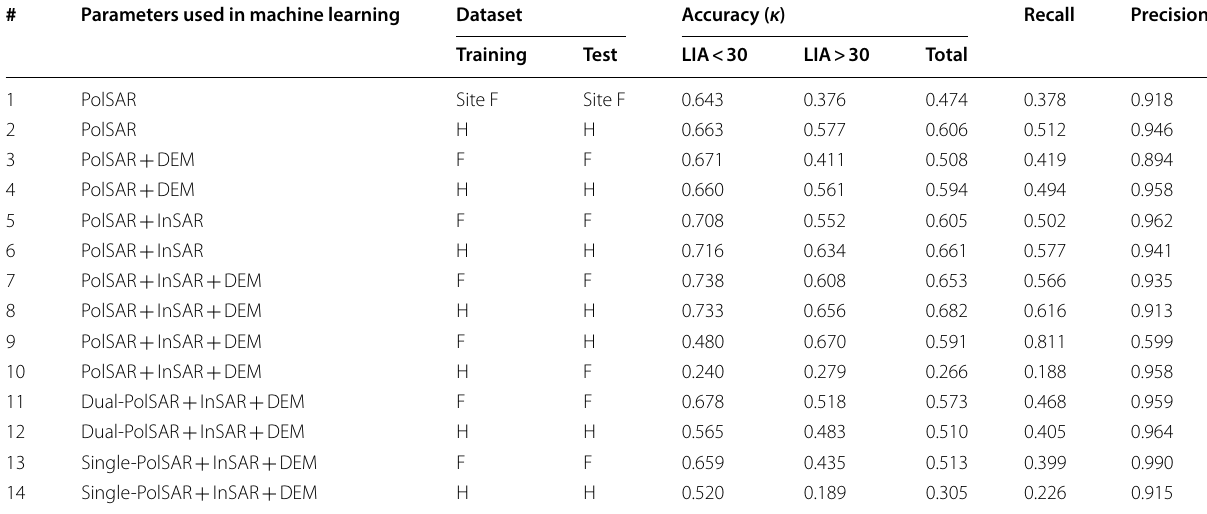
Table 4 Accuracies of landslide detection by the supervised classification for various conditions # Parameters used in machine